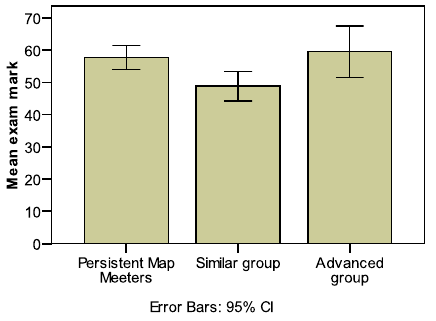
FIG. 9. (cid:1) Color online (cid:2) Mean total exam score for the persistent map meeters and the similar and advanced groups.